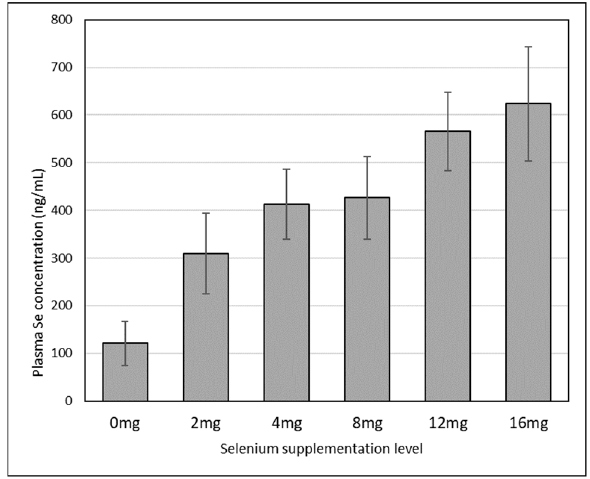
Figure 1. Changes in camel serum Se concentration according to the level of oral Se supplementation (reported by Faye and Seboussi, 2009 [121]).